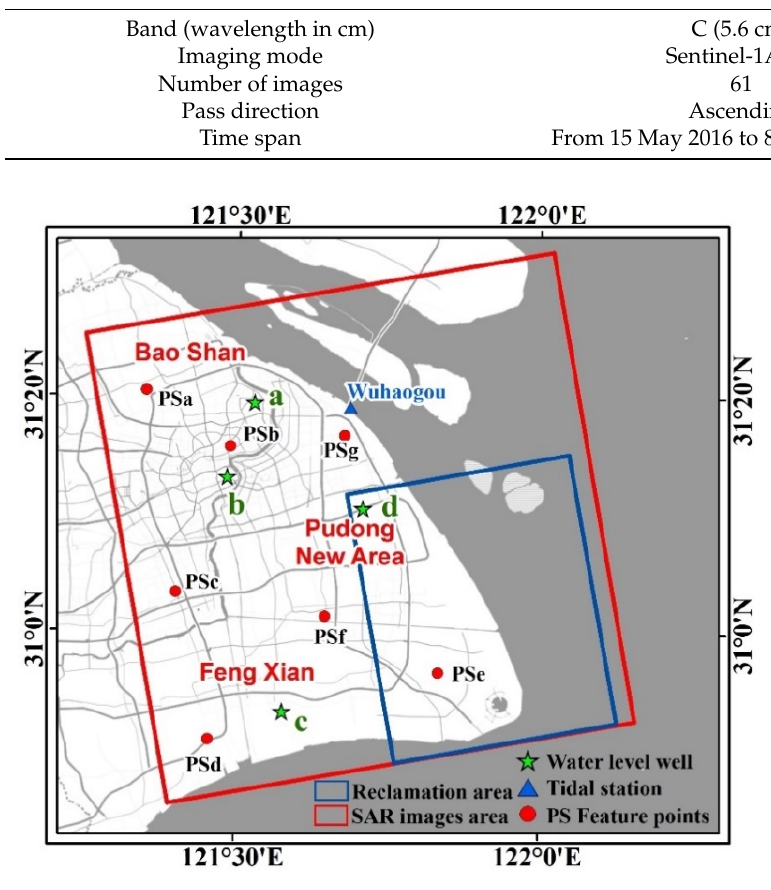
Figure 2. Spatial and temporal distribution of data. The green star is the location of water level wells, the blue triangle is the tide monitoring station of Wuhaogou, and the red circle is the location of PS feature points with different spatial distributions.